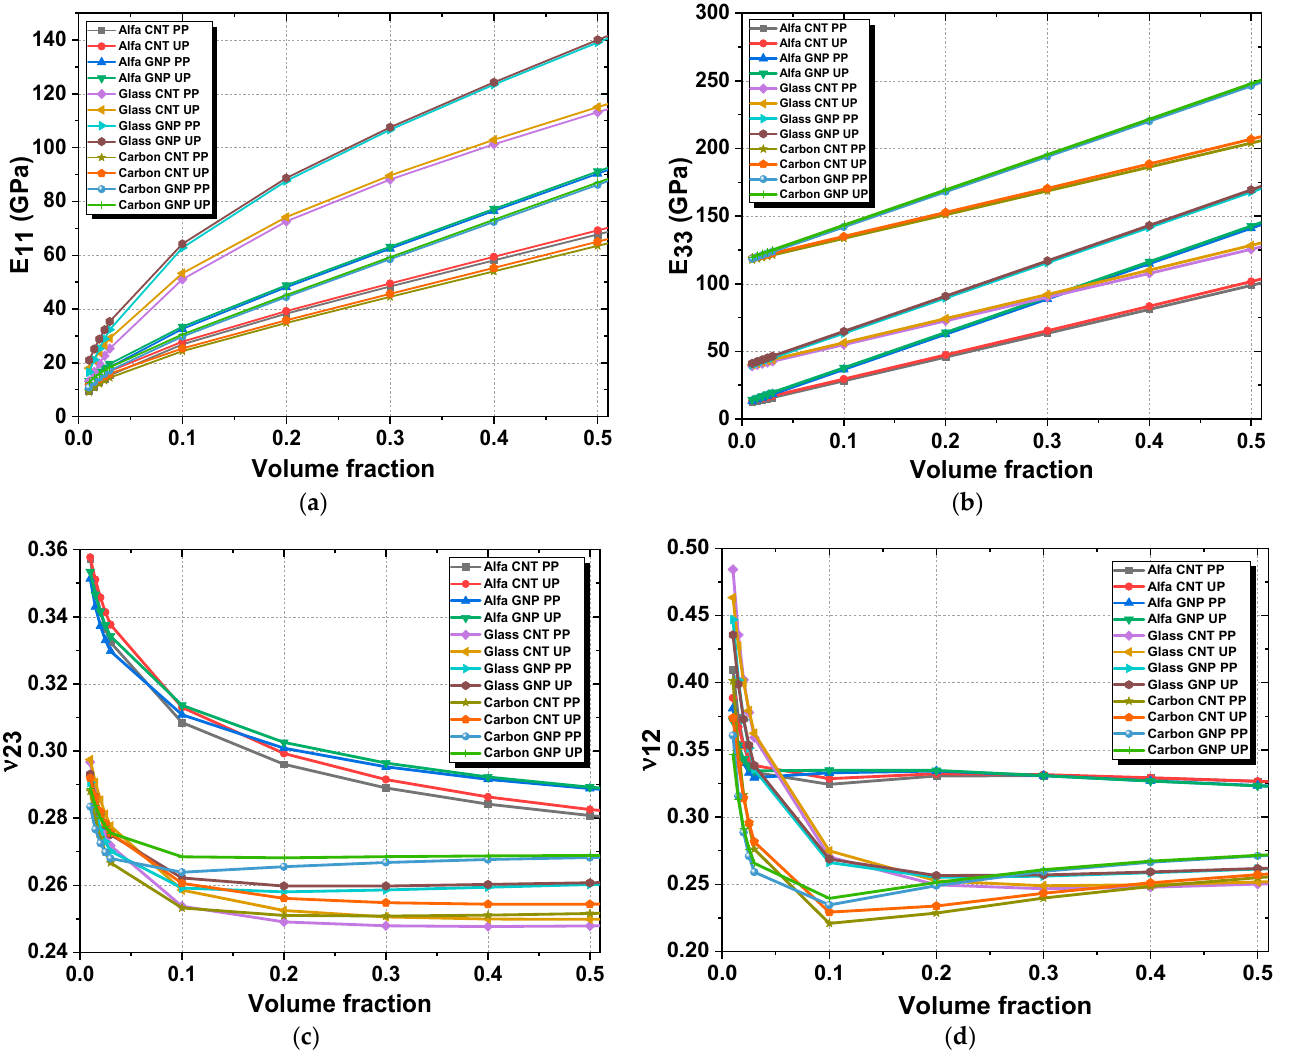
Figure 9. Comparison of the transversely elastic moduli of an effective matrix reinforced by aligned fibers, by using the numerical method with Digimat MF: ( a ) E 11 axial Young’s modulus; ( b ) E 22 in-plane Young’s modulus; ( c ) ν 23 in-plane Poisson’s ratio; and ( d ) ν 12 axial Poisson’s